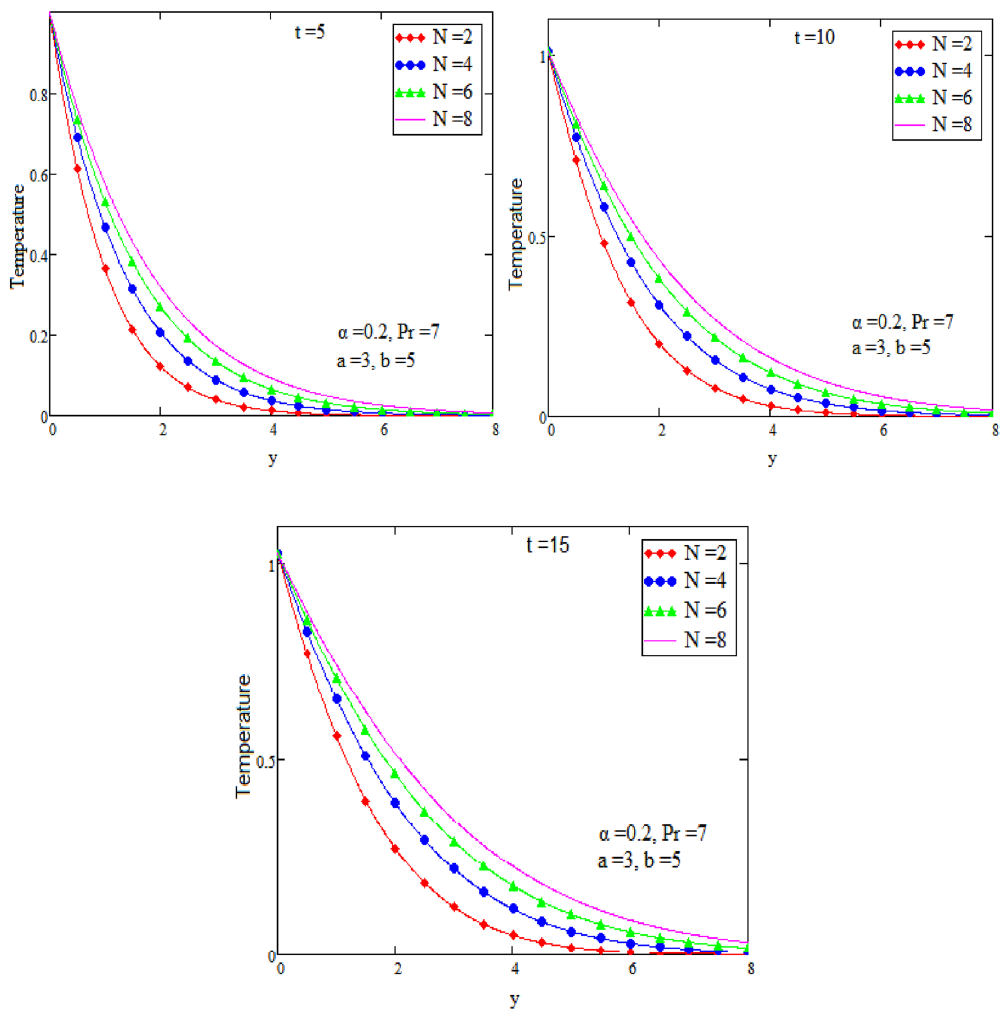
Figure 4. Graph of temperature for different value of radiation